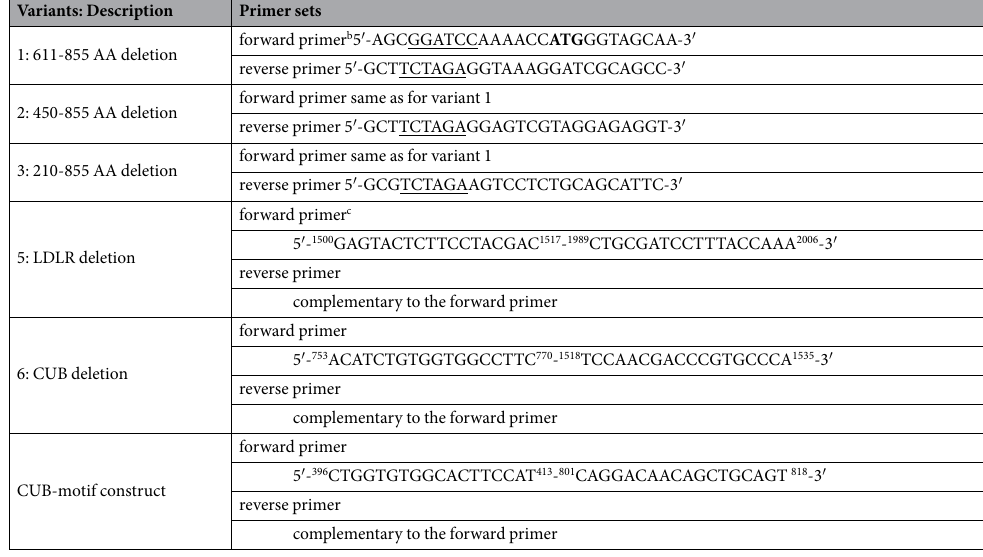
Table 1. MTP variants and the primer sets used to obtain them. a a The resulting protein constructs are shown in Fig. 2A and Fig. 3A. b The underlined letters are the restriction enzyme sites included for cloning; the bold letters are the first methionine of MTP cDNA. c 3 or 4 digit shown in the primer sequences are the number of the nucleotides corresponding to the mouse MTP cDNA. The resulted MTP fragment will contain deletion between the two adjacent nucleotide numbered in the middle of the forward